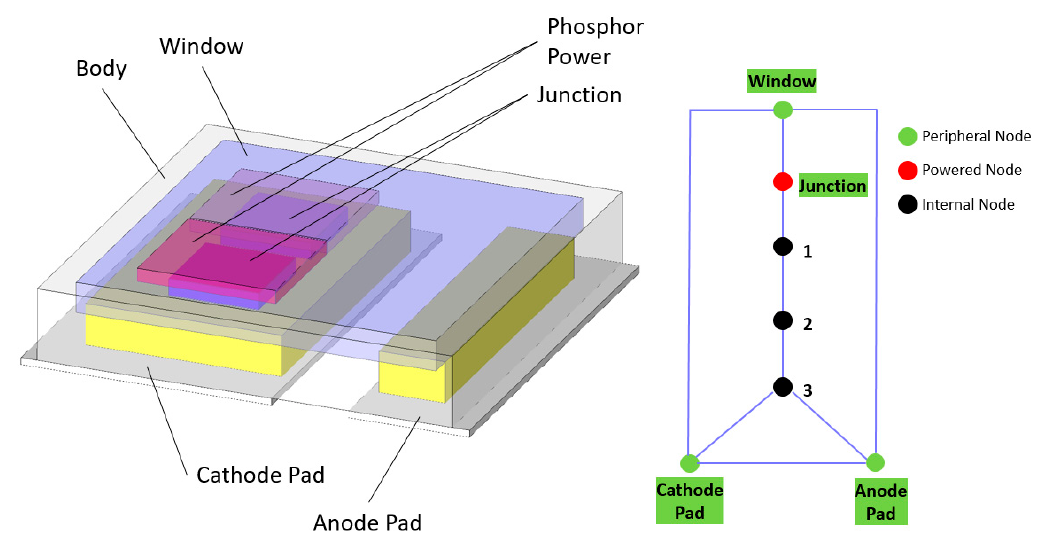
Figure 3. Nichia NF2L757GRT-V1 3D detailed model and equivalent CTM nodal topology.